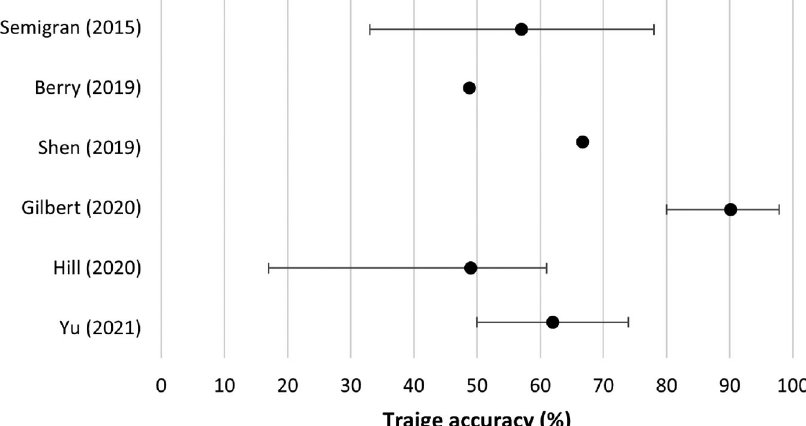
Fig. 4 Mean accuracy of triage information given by symptom checkers in each study. Error bars signify the range of accuracy of different symptom checkers for the same patient/vignette